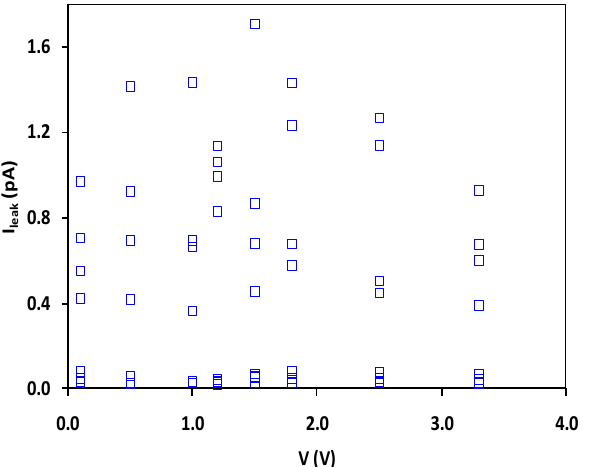
Figure 28. Measured ESD triggering voltages for sample ESD devices show V t1 tunability by design [49].